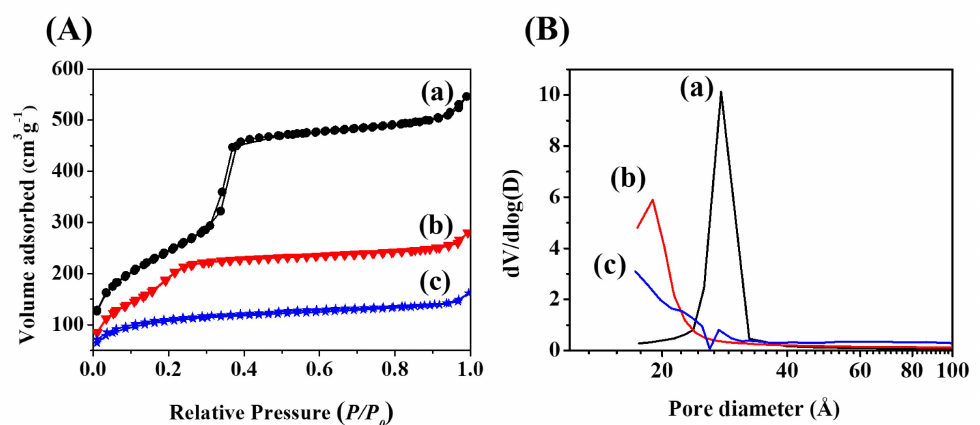
Figure 8. N 2 adsorption-desorption isotherms ( A ) and pore size distributions ( B ) of (a) MCM-41,